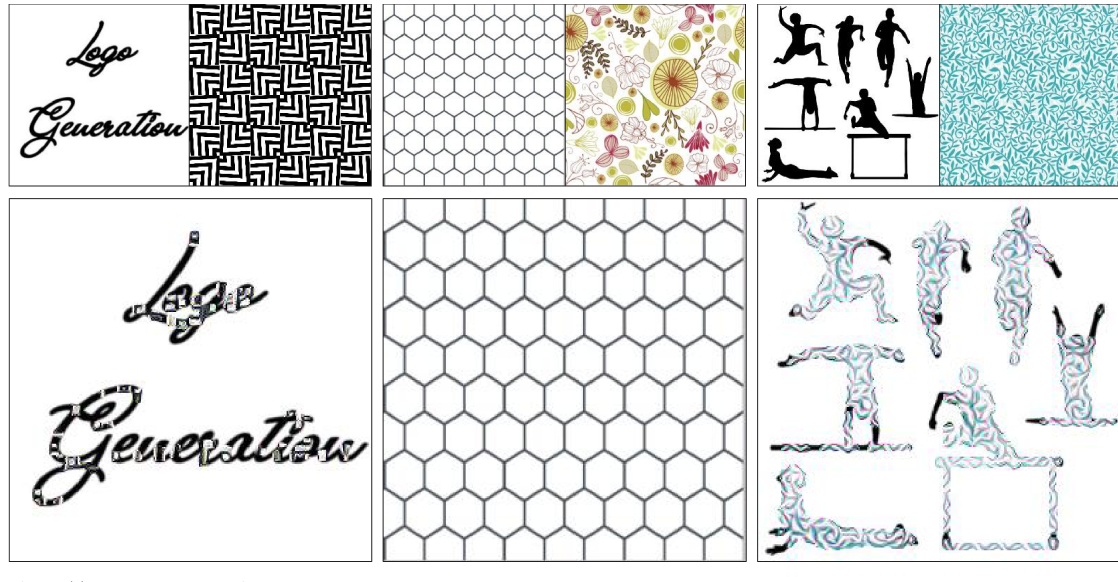
Fig 16. Too narrow content